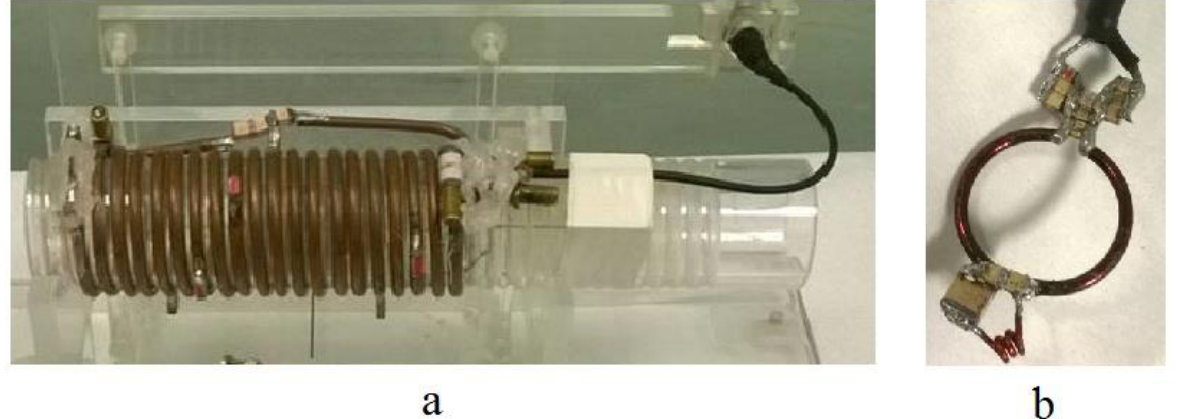
Figure 13. RF coils for hyperpolarized 13 C studies in small animal models, to be integrated with the clinical scanner. ( a ) 1H solenoid; ( b ) 13 C circular coil.